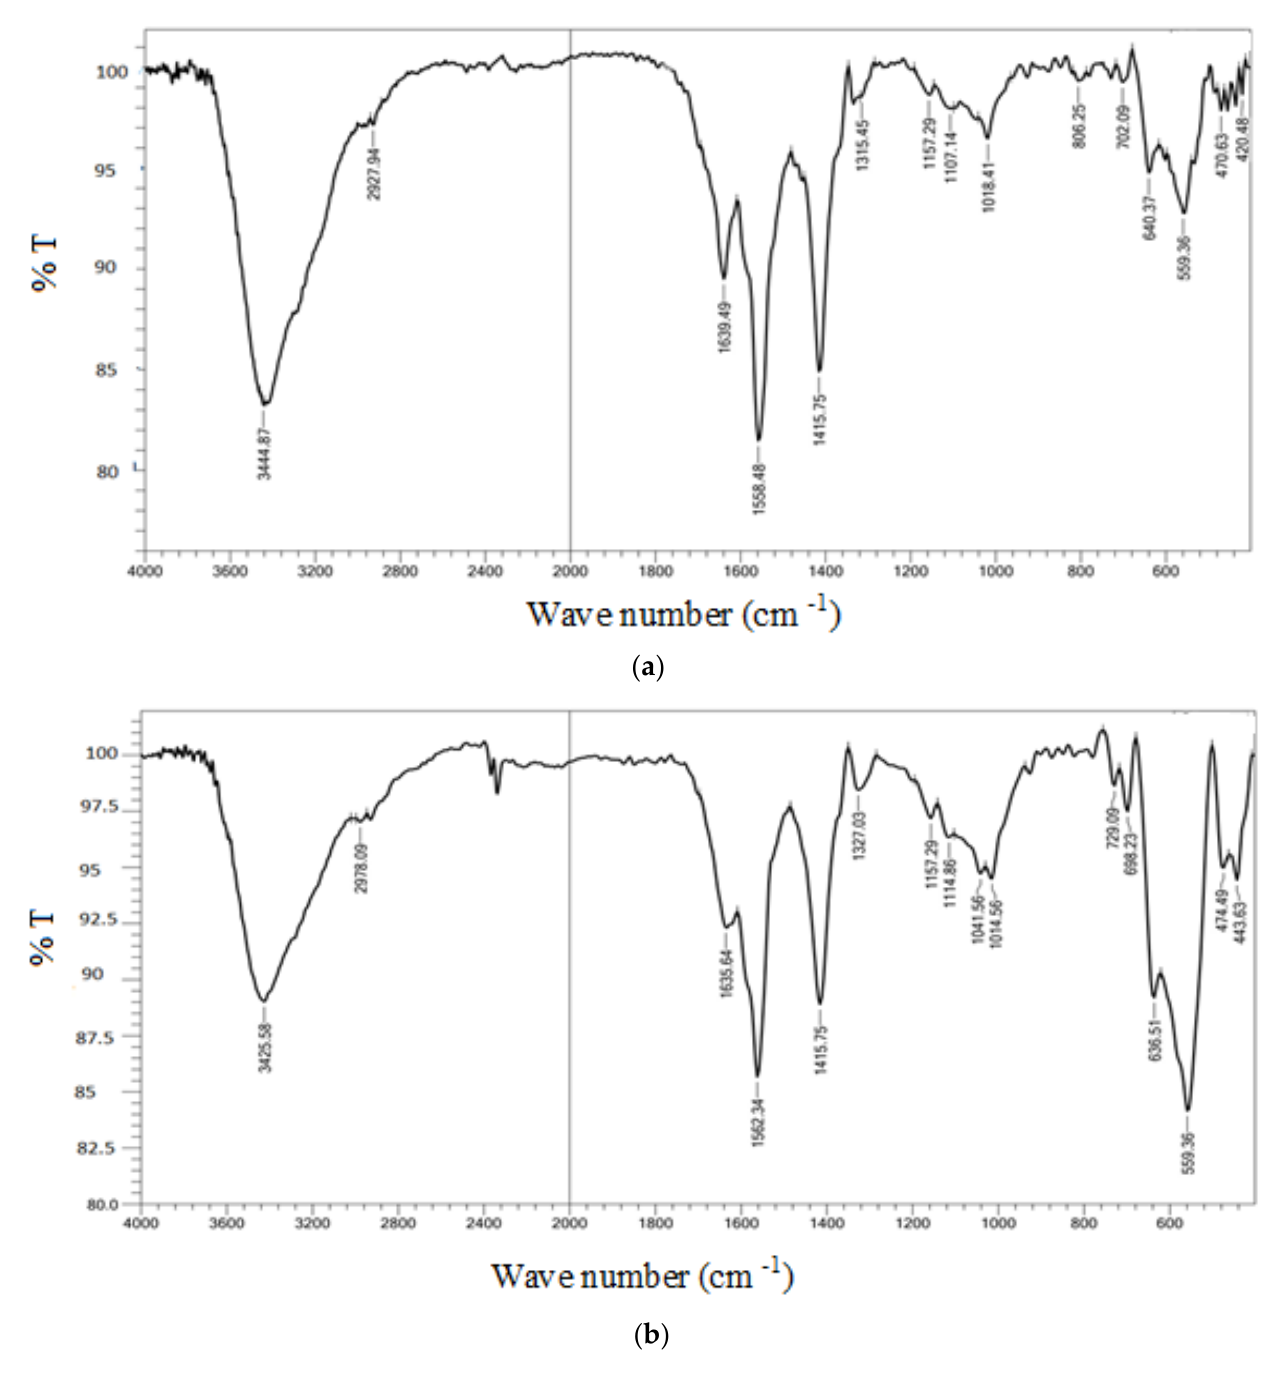
Figure 2. Fe 3 O 4 /CA hysteresis. The pattern of XRD for the Fe 3 O 4 /CA is presented in Figure 3. The magnetite charac- teristic peak can be seen at 2 Ɵ = 30.3°, 35.8°, 43.01°, 54.14°, 57.5°, and 62.6°, the 2 Ɵ of 35.8° is the high intensity. These diffraction peaks are according to the corresponding indices of (220), (311), (400), (422), (511), and (440), and a comparison with the JCPDS card No. 79- 0418 indicates that Fe 3 O 4 /CA particles clearly matched to Fe 3 O 4 . An equation of Scherrer was applied for calculating the average of the crystal size, as follows [33]: